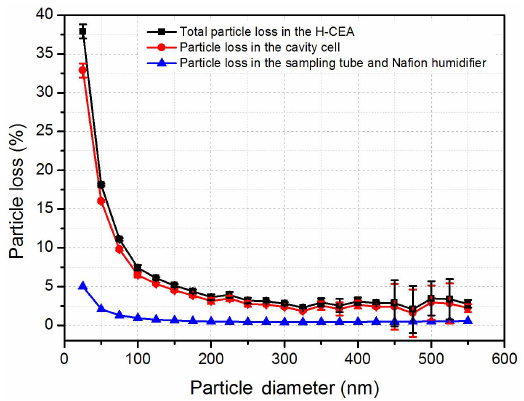
Figure 3. Size-resolved particle loss in the newly developed H-CEA instrument, which was the sum of the particle losses in the cavity cell and in the sampling tube and Nafion humidifier. Each point was the result of 25 measurements.